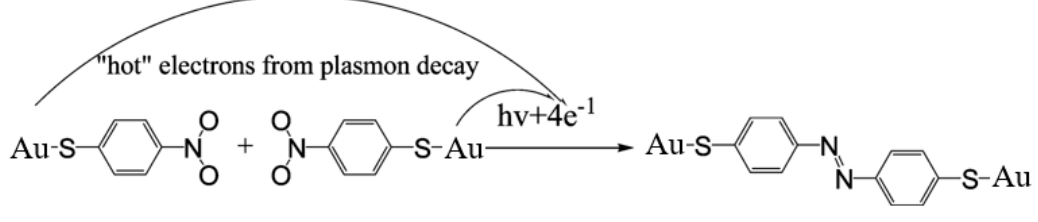
Figure 5. Mechanism of plasmon-assisted surface-catalyzed reaction [29].